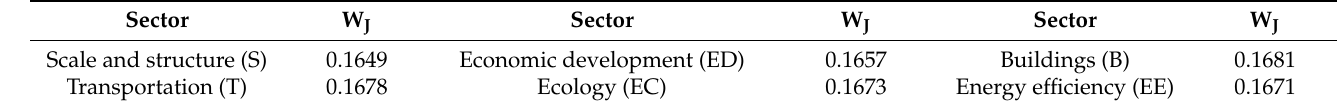
Table 3. Entropy weight statistics.